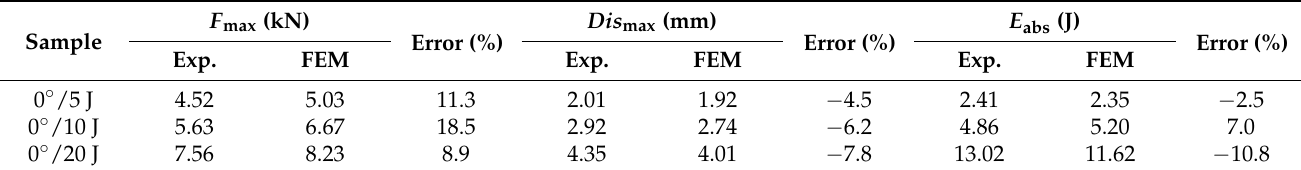
Table 2. Comparison of predictive and experimental data.